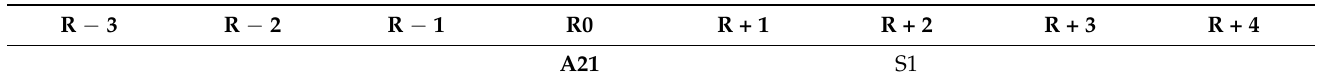
Table 4. Conditioned behaviors associated with the behavior of associating personal emotions to personal behaviors (A21).